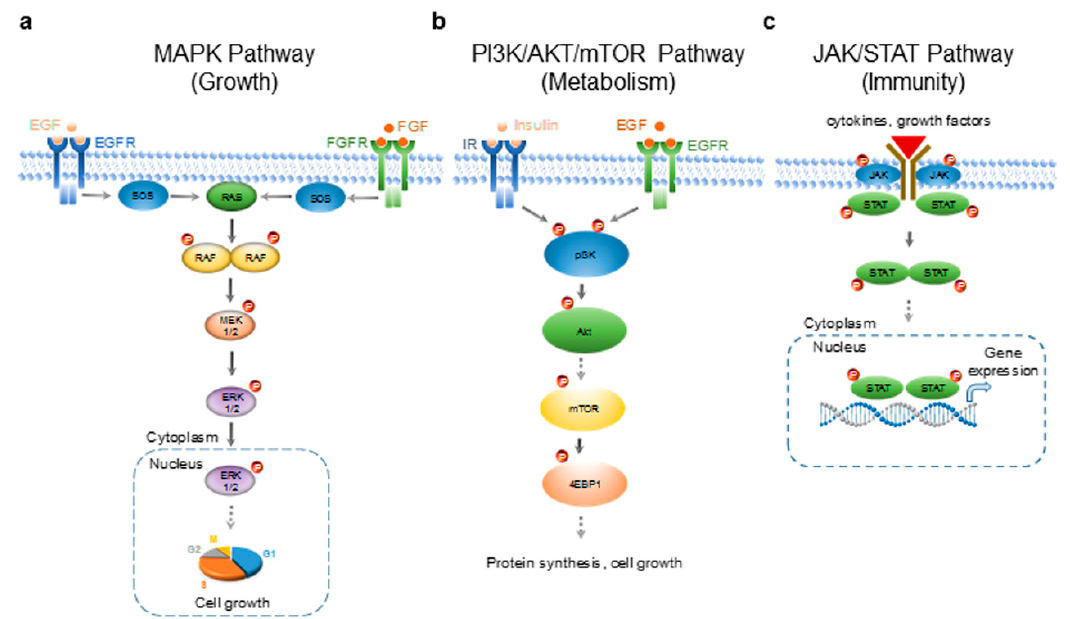
Figure 1. Signaling pathways selected for the evaluation of the biological e ff ects of essential oils. ( a ) The mitogen-activated protein kinase (MAPK) signaling pathway that regulates cell growth and di ff erentiation. EGF—epidermal growth factor; EGFR—epidermal growth factor receptor; FGF—fibroblast growth factor; FGFR—fibroblast growth factor receptor; SOS—guanine nucleotide exchange factors; RAS—small GTPases; serine / threonine-specific protein kinases; MEK1 /